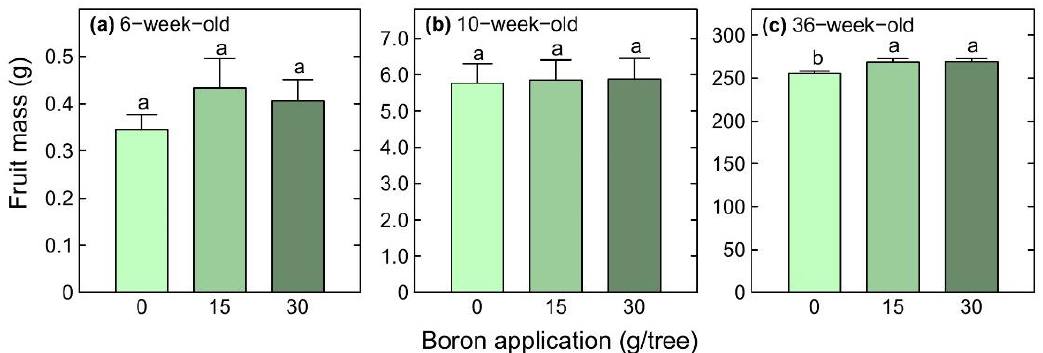
Figure 7. Masses of individual fruitlets or fruit at ( a ) 6 weeks, ( b ) 10 weeks and ( c ) 36 weeks after peak anthesis on Hass avocado trees treated with 0, 15 or 30 g boron (B) per tree prior to anthesis. Means (+SE) with different letters are significantly different (generalised linear models, p < 0.05, n = 81–91 6-week-old fruitlets, n = 99–100 10-week-old fruitlets, and n = 160 mature fruit). Table 1. Length, diameter, flesh mass and seed mass of mature fruit from Hass avocado trees treated with 0, 15 or 30 g boron per tree prior to peak anthesis.